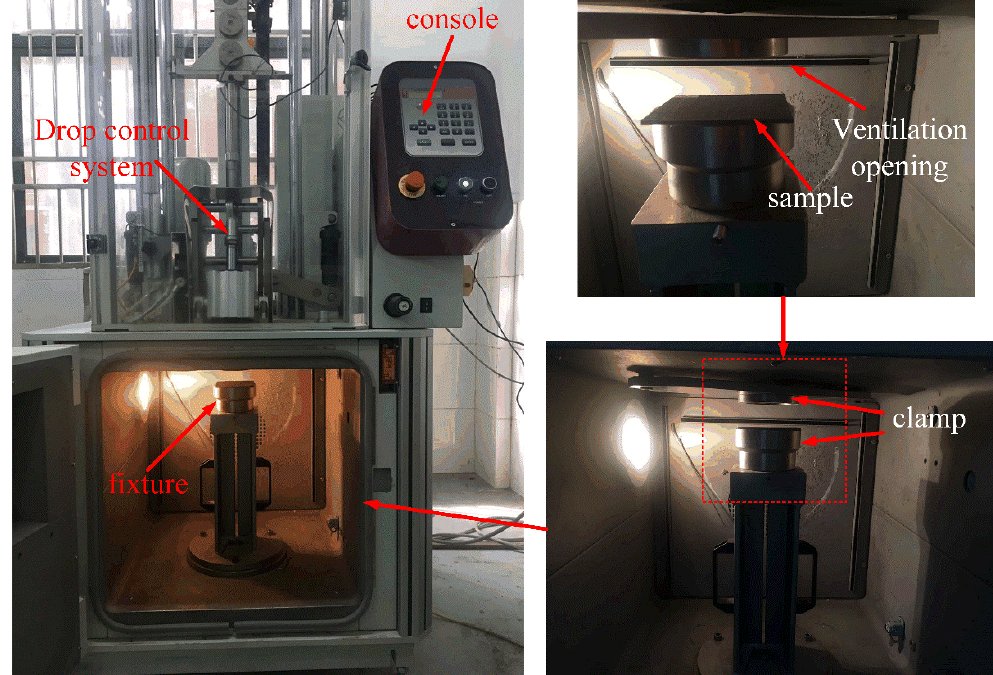
Figure 4. Testing setup of the low velocity impact test.